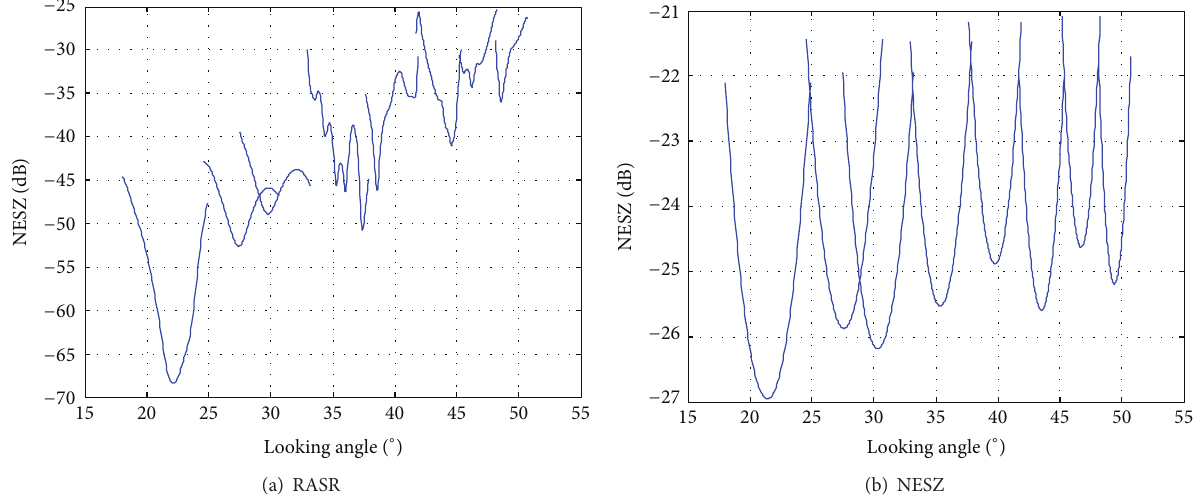
Figure 8: System performances of the designed SAR system with the proposed